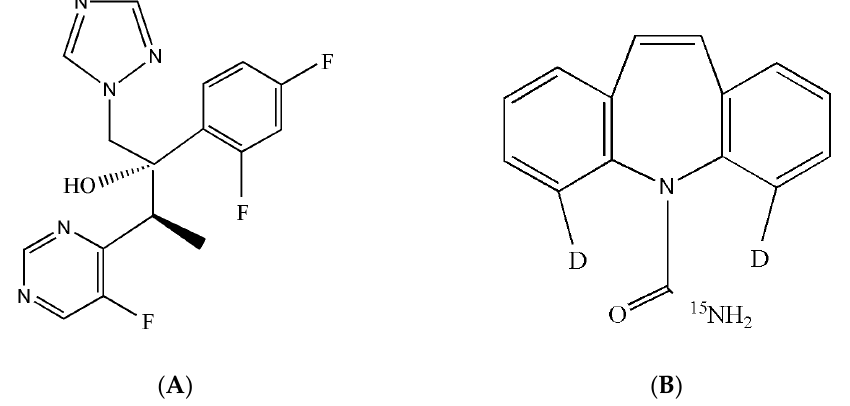
Figure 7. Structures of ( A ) voriconazole and ( B ) Carbamazepine-d2,15N.